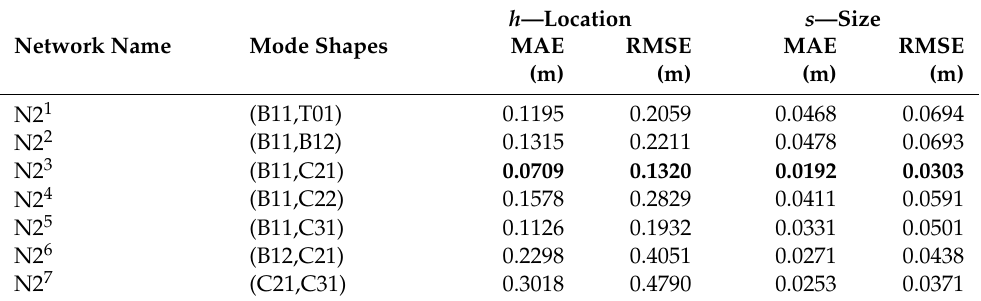
Table 5. The results of the identification of { h , s } on the basis of two mode shapes.